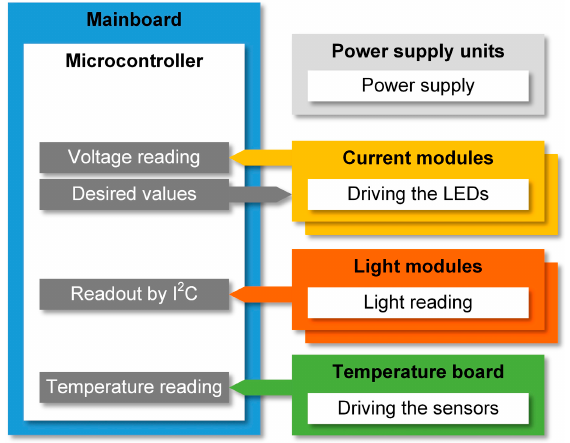
Figure 2. Structure of the test system.